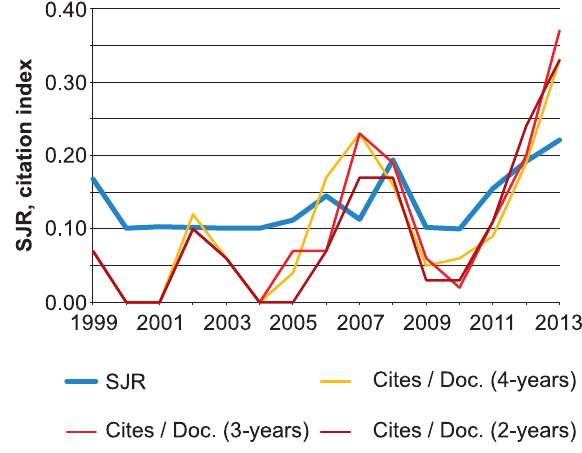
Fig. 1. Variability of SJr index and a 2-year, 3-year